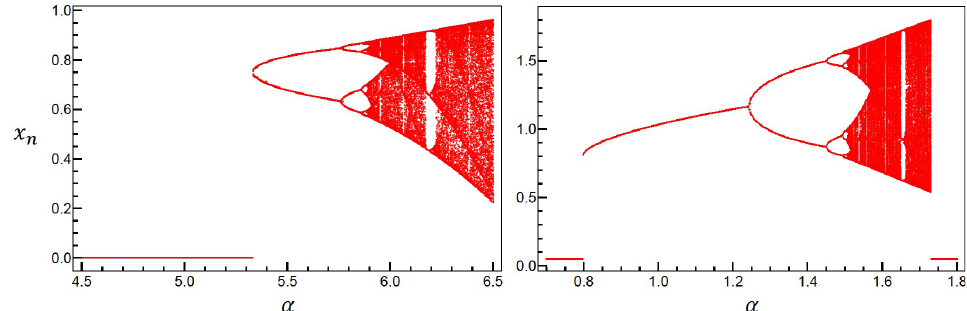
Figure 12: Amplitudes of the iterates x as a function of the parameter α , for the n deterministic part of model (9) (left) and for model (13) (right) assuming a constant α and replacing the additive noise with its average value. In both cases, one observes two stable fixed points, corresponding to zero and non-zero solutions, and the cascade of period doubling bifurcations that characterizes the route to a chaotic